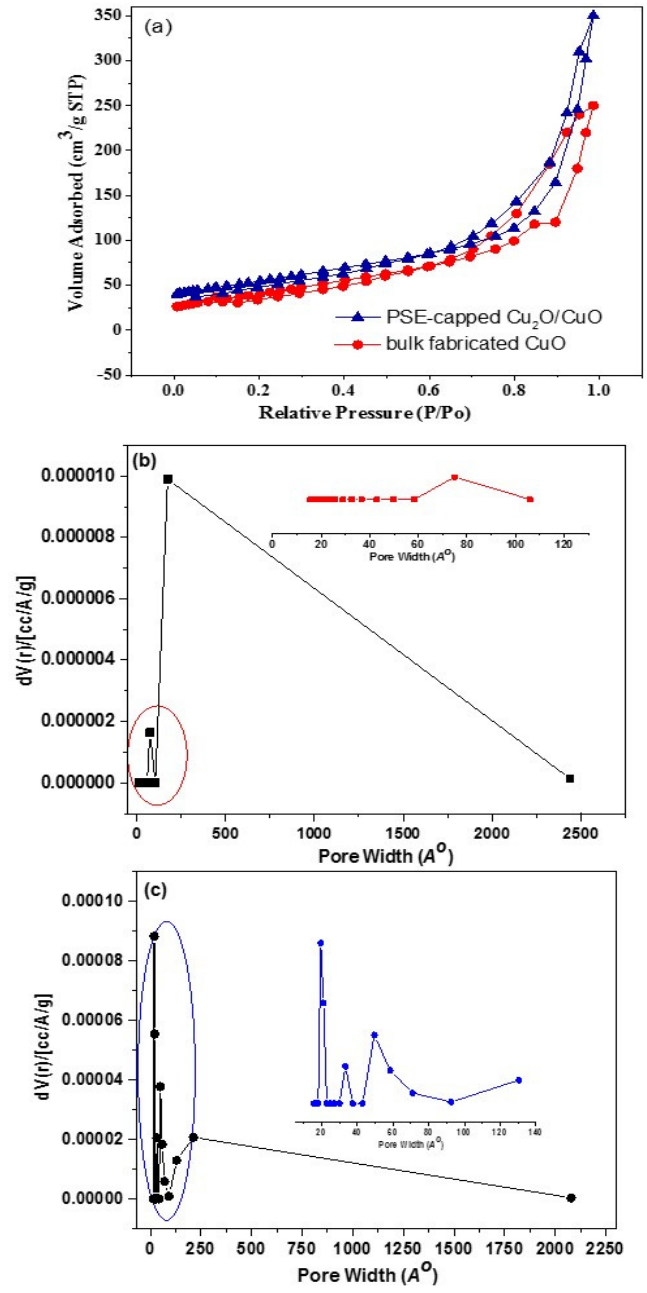
Figure 5. ( a ) N 2 adsorption / desorption isotherms and pore size distribution of ( b ) bulk fabricated CuO and ( c ) PSE-capped Cu 2 O / CuO materials fabricated by the aqueous solution combustion approach.